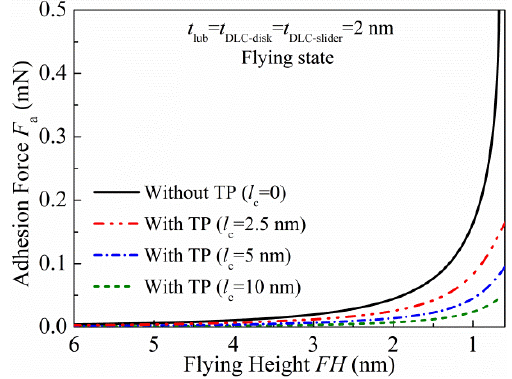
Figure 8. Effects of TP on the adhesion force under different flying height FH.